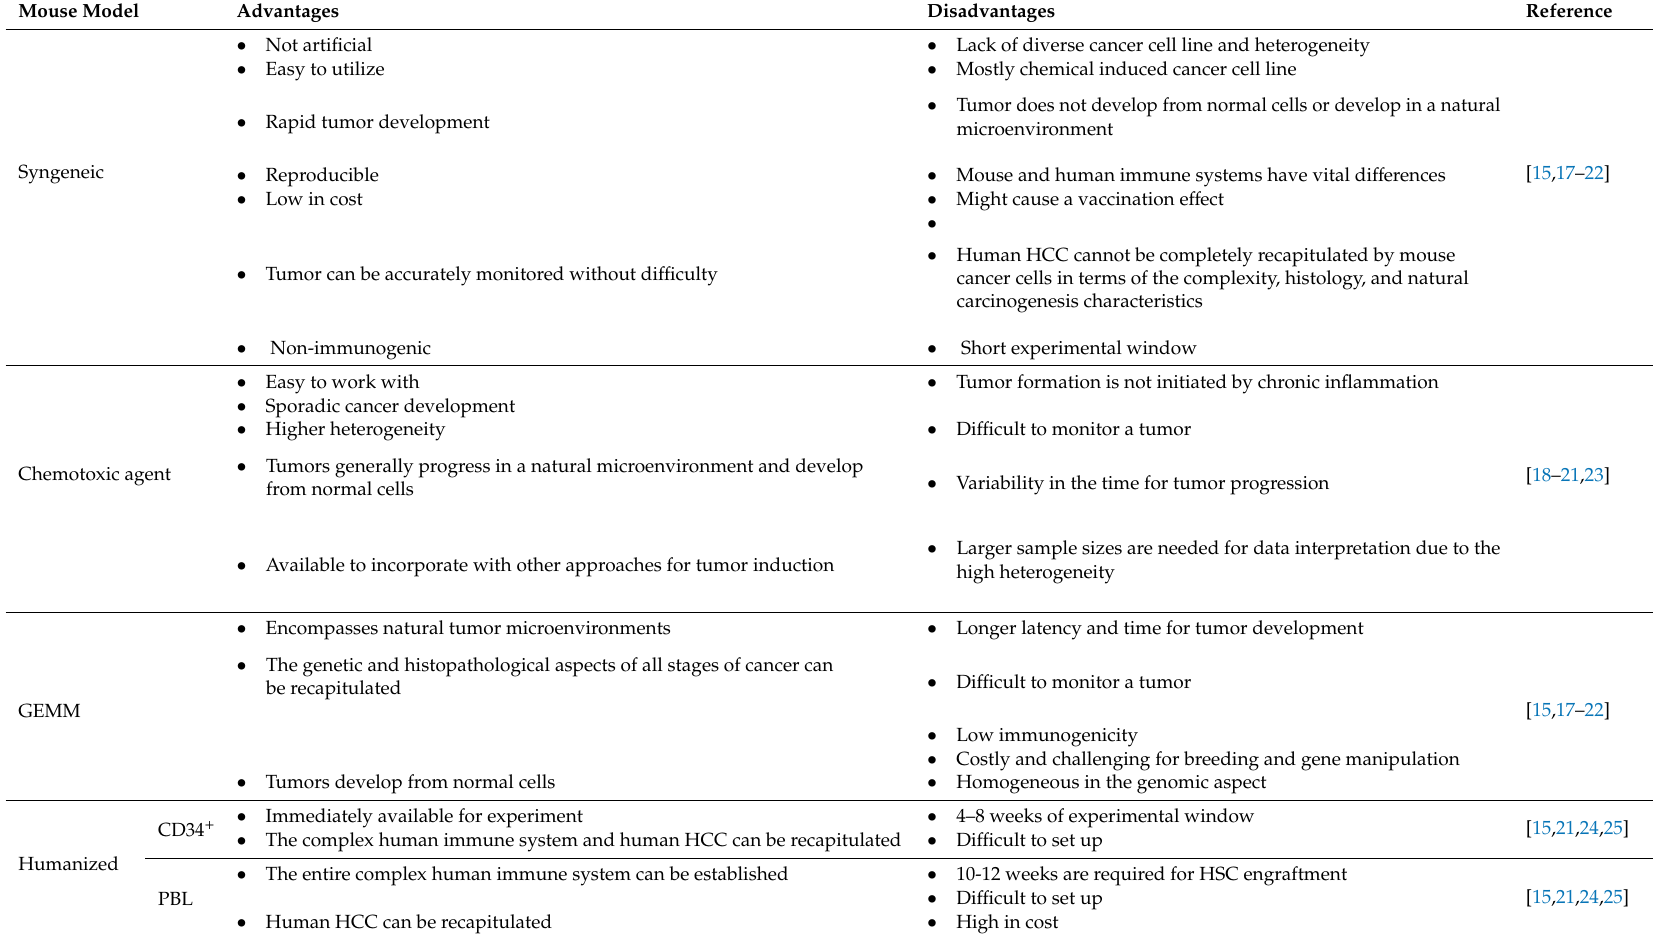
Table 1. The advantages and disadvantages of murine models for immunotherapy studies of hepatocellular carcinoma